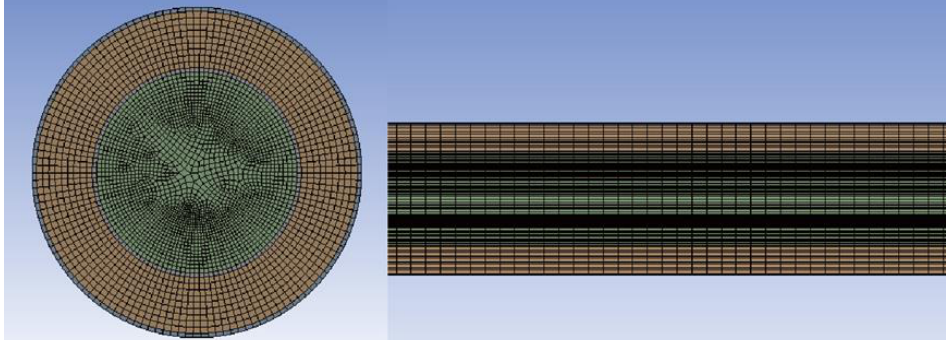
Energies 2021 , 14 , x FOR PEER REVIEW